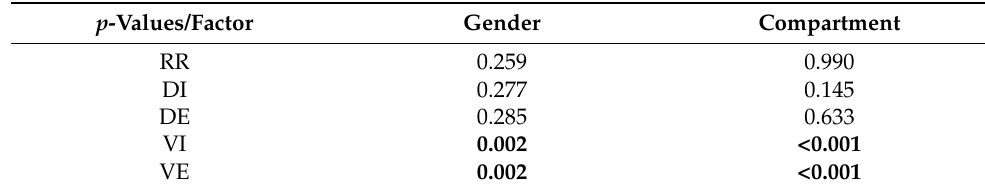
Table 5. Outcomes of two-way ANOVA for the analysis of gender (2 levels: female and male) and compartment (3 levels: CW, RC, and AB) on the respiratory parameters measuredbyoptoelectronic plethysmography (data reported in Figure 6). The p -values are highlighted in bold when reaching significance ( p < 0.05).